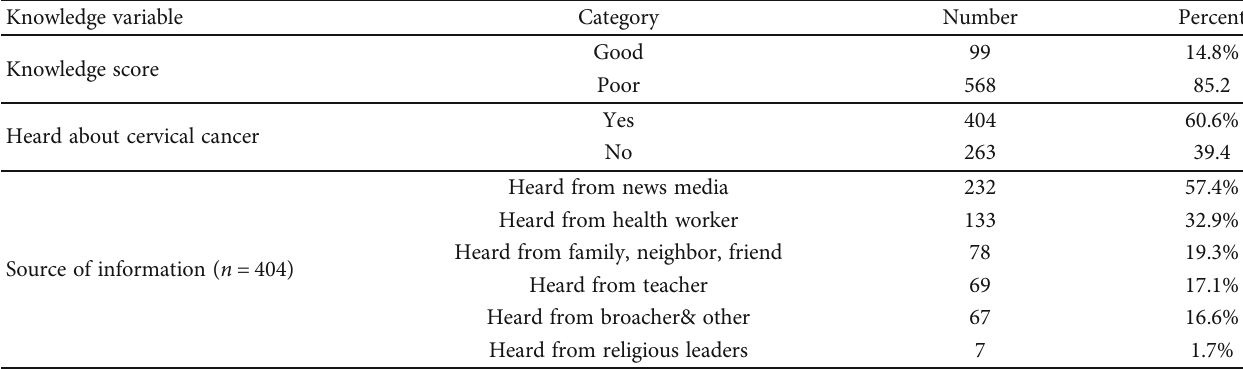
Table 2: Respondents ’ knowledge about cervical cancer screening at Adama Science and Technology University, Adama, Ethiopia, May 2014.